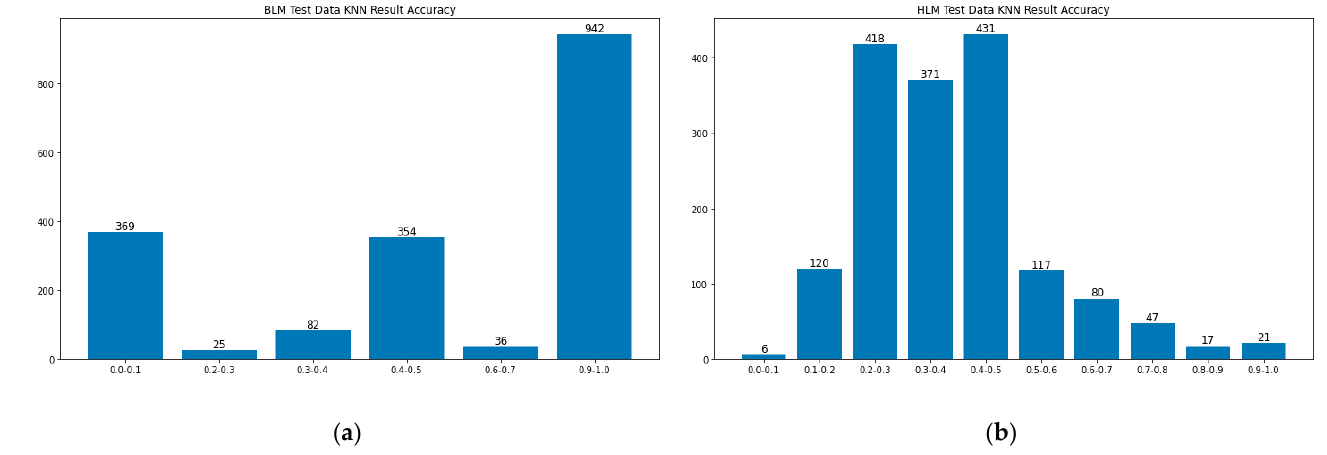
Figure 8. Accuracy of: ( a ) BLM test cases using KNN; ( b ) HLM test cases using KNN.